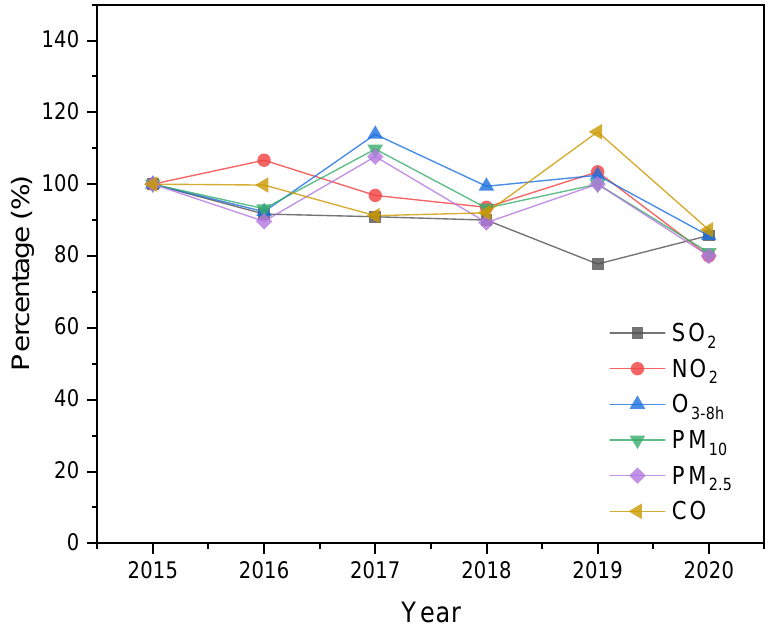
Figure 1. Trend of rates of changes in air pollutant’s annual averages in the GBA. Governments in the PRD, Hong Kong and Macao from 2015 to 2020 had promulgated structure, promoting clean power structure, retiring old vehicles, and promoting